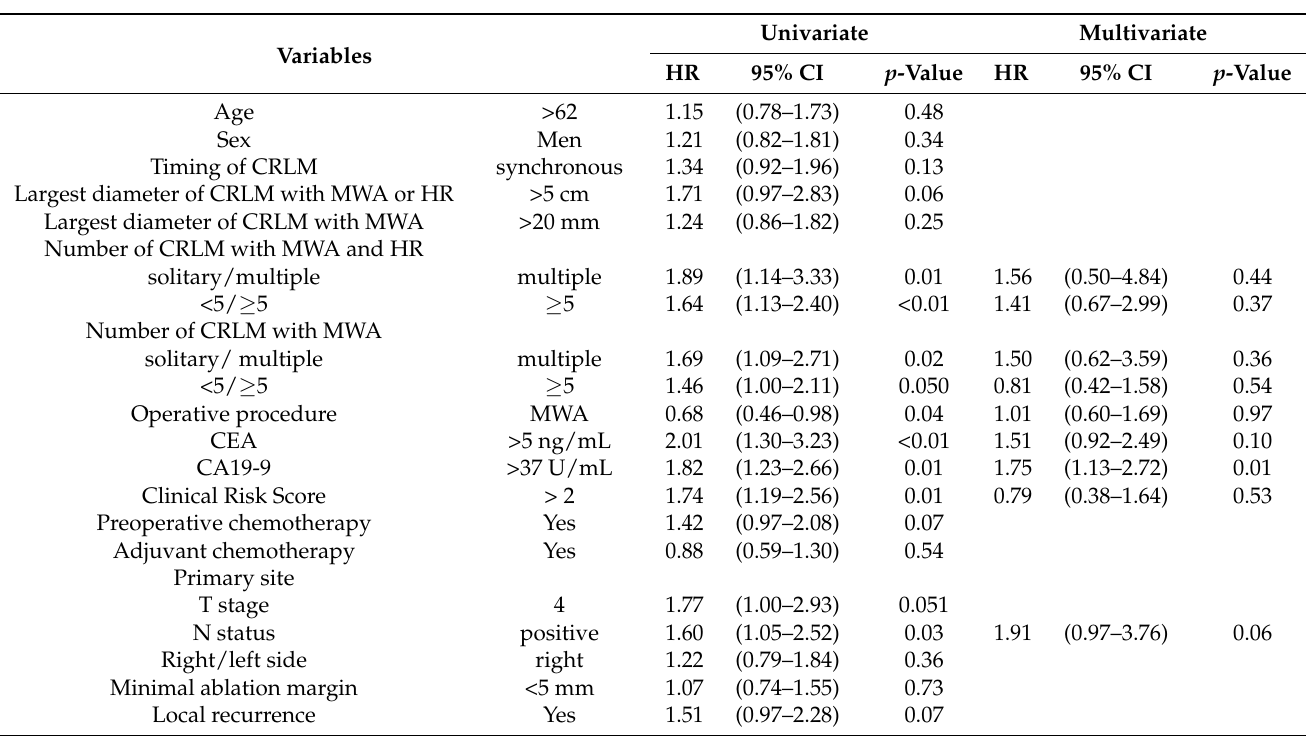
Table 6. Univariate and multivariate analysis of prognostic factors for overall survival in patients with CRLM treated with